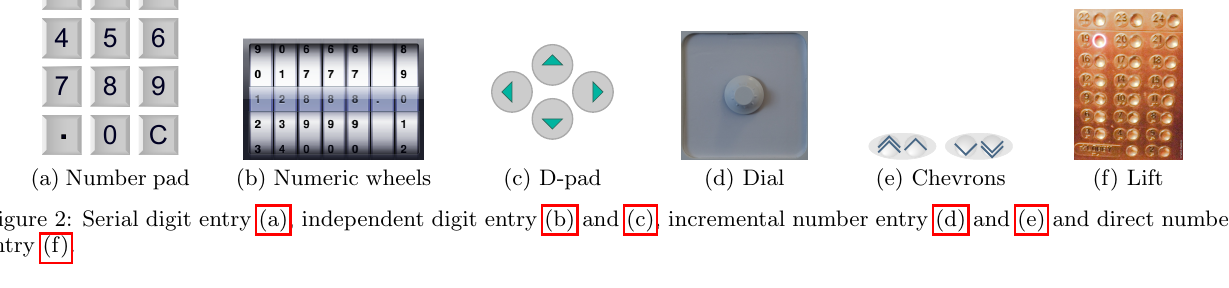
Figure 2: Serial digit entry (a), independent digit entry (b) and (c), incremental number entry (d) and (e) and direct number entry